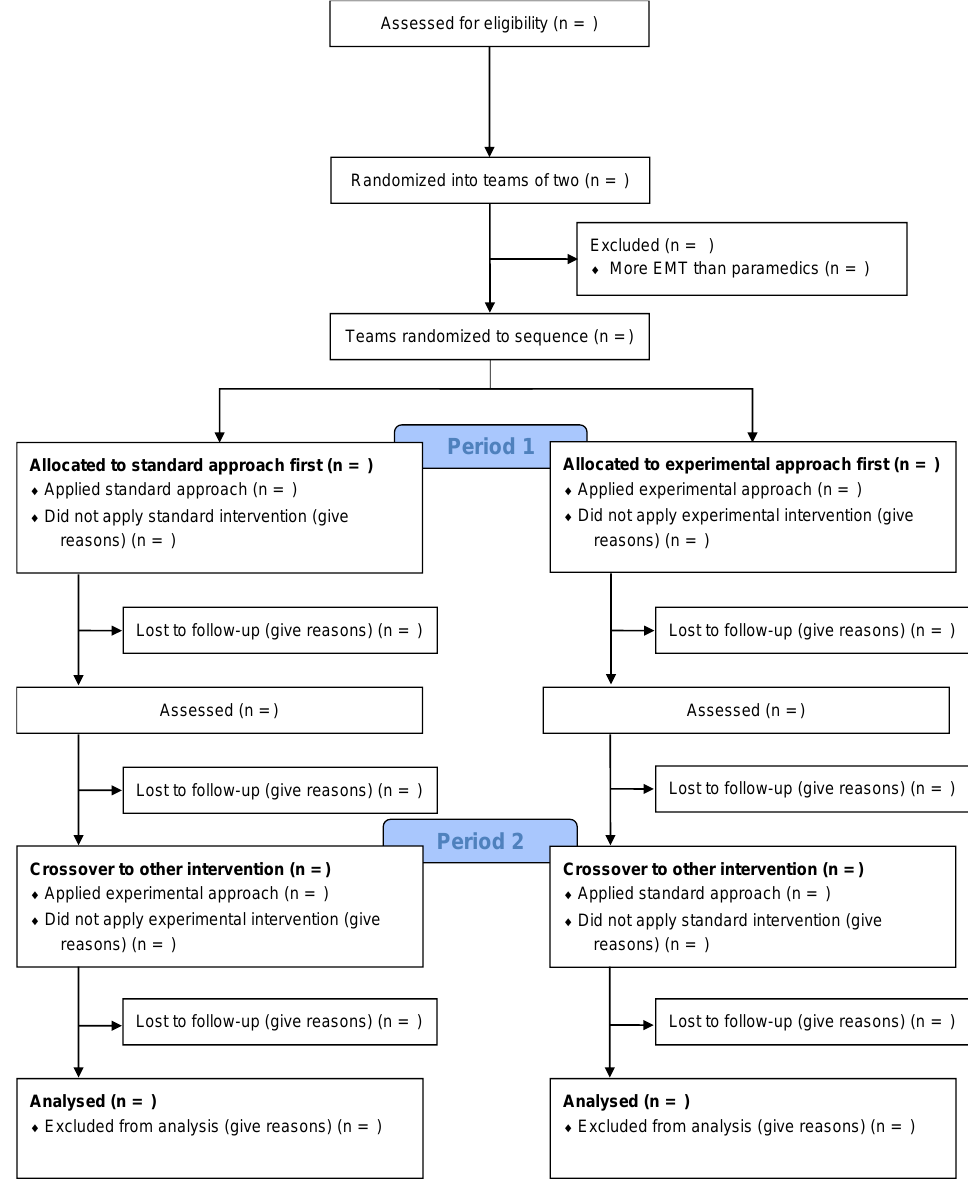
Figure 1. Study flowchart.